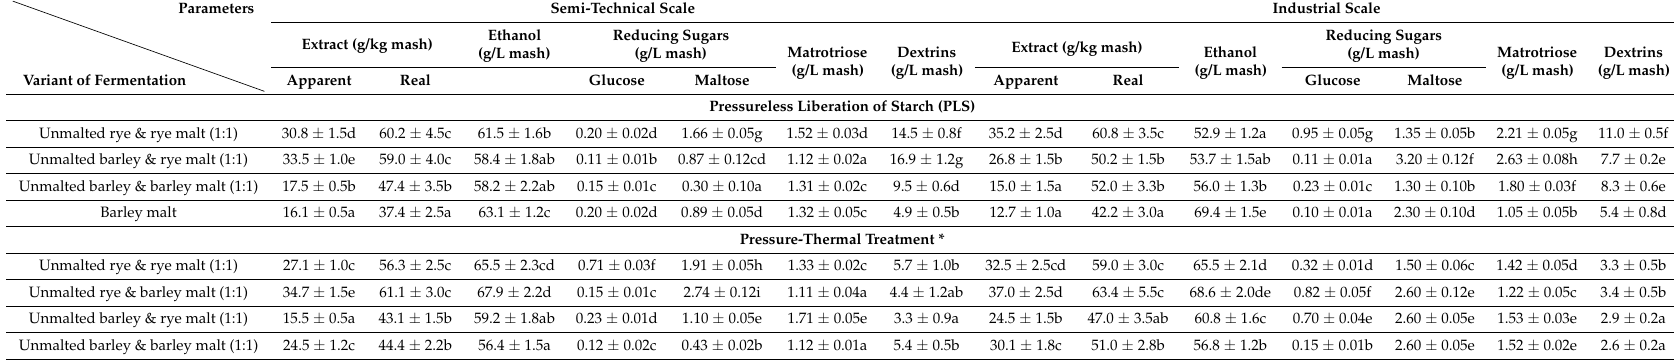
* Pressure-thermal treatment was applied only for unmalted cereals; Results expressed as mean values ± SE ( n = 3); mean values in columns with different letters are significantly different ( p <